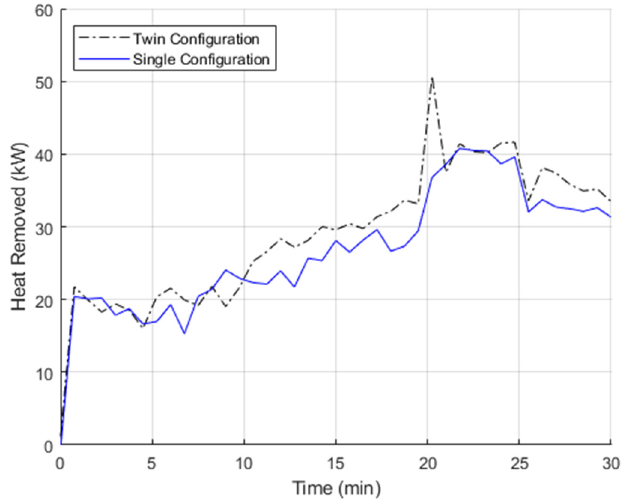
Figure 4. Heat removal rate vs. time for single- and two-radiator configurations.